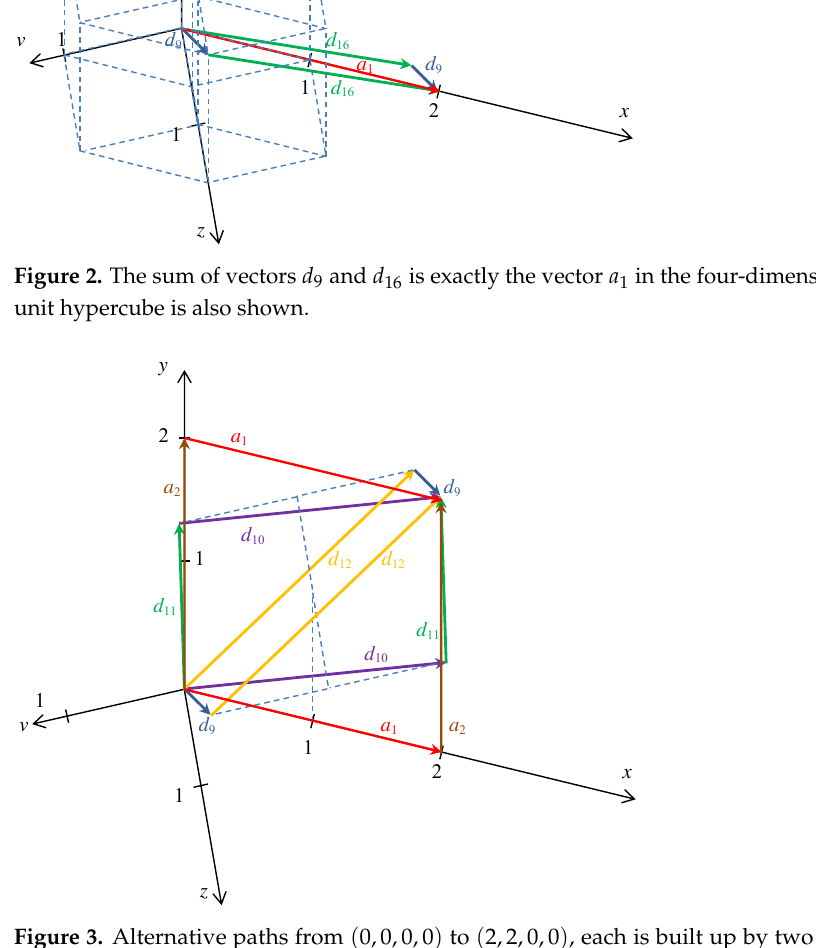
Figure 3. Alternative paths from ( 0,0,0,0 ) to ( 2,2,0,0 ) , each is built up by two steps, in the four- dimensional BCC